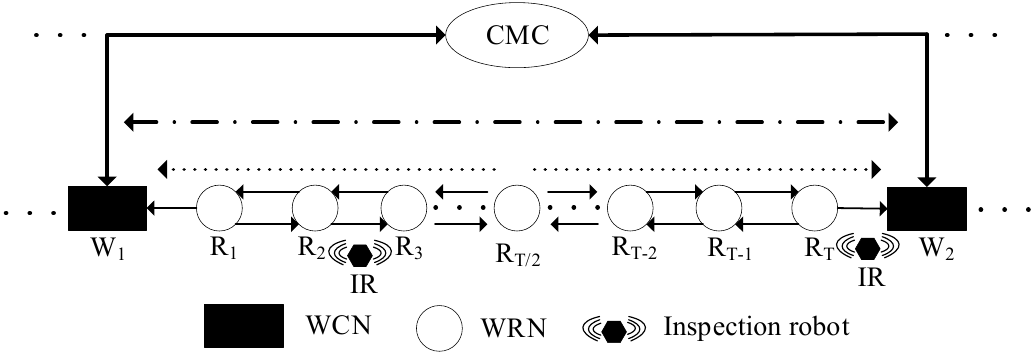
Figure 6. Robot hybrid hierarchical network (RHHN) model.